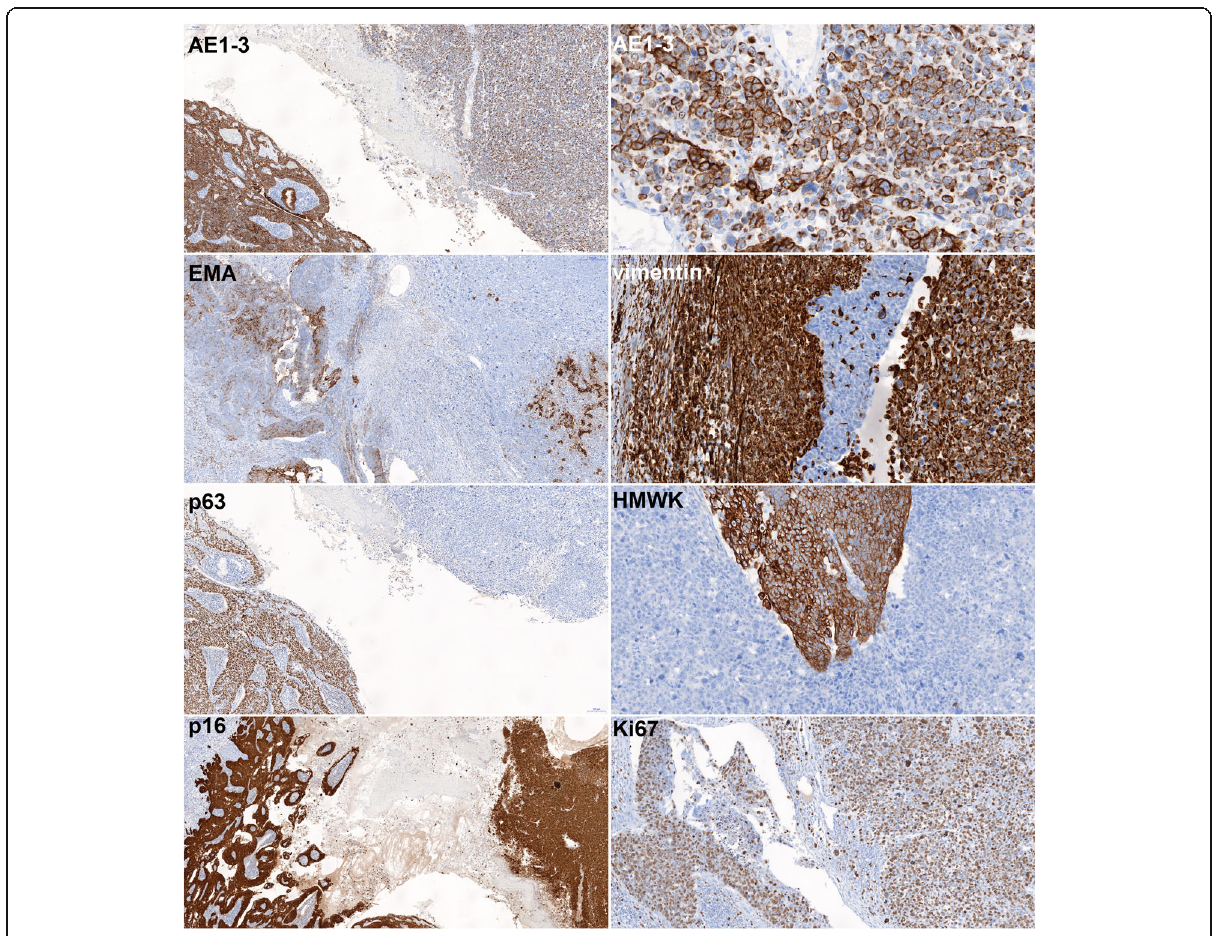
Fig. 3 Scans of histological slides stained immunohistochemically. AE1/3 (11,2x): note the strong diffuse positivity in the epithelioid part of tumor (left) and weaker, but unequivocal diffuse positivity in the sarcomatoid part, in the upper right corner in detail (5,9x). EMA (7,8x): Note the heterogenous positivity in both epithelioid (left) and sarcomatoid (right) parts of the tumor. Vimentin (29,2x): note the strong positivity in the cervical stroma (left) and in the sarcomatoid part (right) and negativity in the accompanying HSIL (in the middle). P63 (11,2x): note the diffuse nuclear positivity in the epithelioid part (left) and negativity in the sarcomatoid tumor (right). HMWK (26,5x): note the positivity in the epithelioid tumor bud (in the middle) and full negativity in the sarcomatoid part. P16 (7,1x) note the strong and diffuse positivity in both parts of the tumor. Ki67 (16,6x): note the brisk proliferation activity in approximately 80% of tumor cells in both